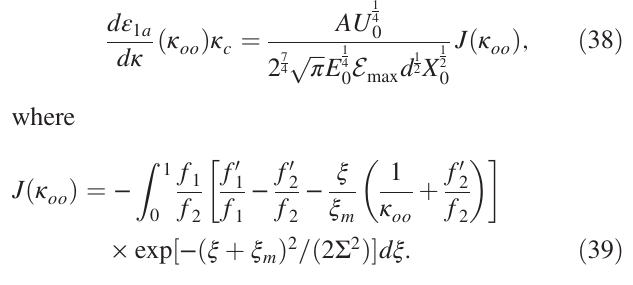
FIG. 3. Losses of transverse energies silicon plane] for volume reflection (a) and for channeling regime (b) as functions of variables ð E − E m Þ = δ E and ð E − E correspondingly. The numbers 1 – 5 near curves are equal to the value of the κ -parameter and correspond to gously the numbers 1 0 – 5 0 are equal to the value of the κ -parameter and correspond to σ E -quantities. The values by three times for good visibility. The particle energy is equal to 400 GeV.